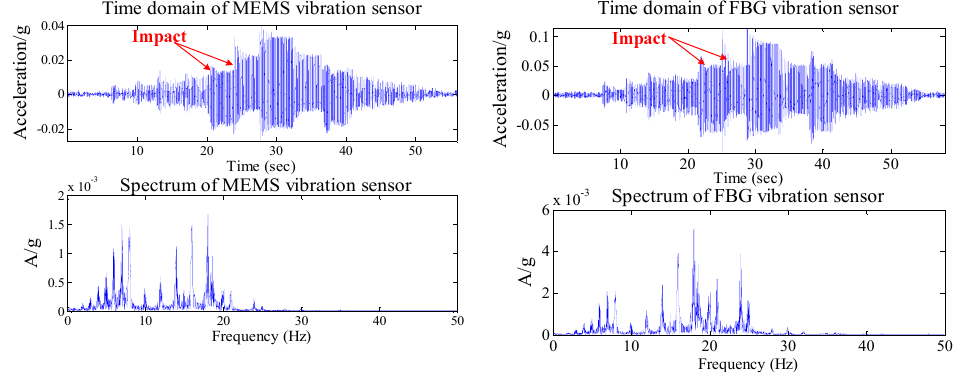
Figure 13. Time domain and spectrum map of the MEMS and FBG micro-vibration sensors for the scanning frequency experiments within 1–8 Hz.